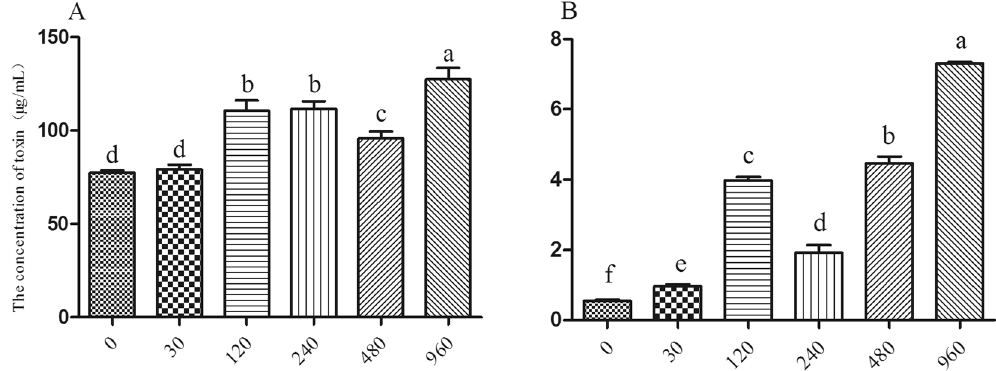
Figure 4. The effects of organic acid mixtures on toxin production by T . helicus. A represents 3A-DON; B represents 15A-DON. Columns with different letters are statistically different (LSD test, p <